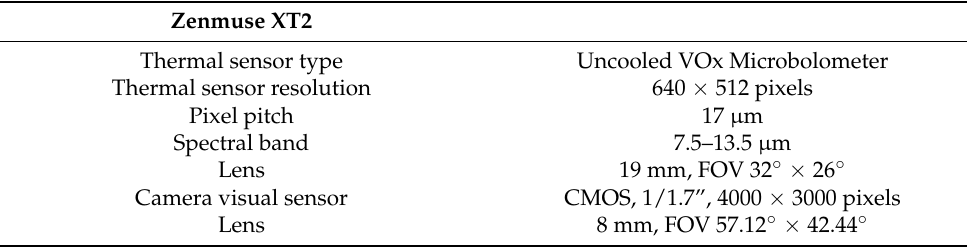
Table 1. Thermal and RGB sensors specification.